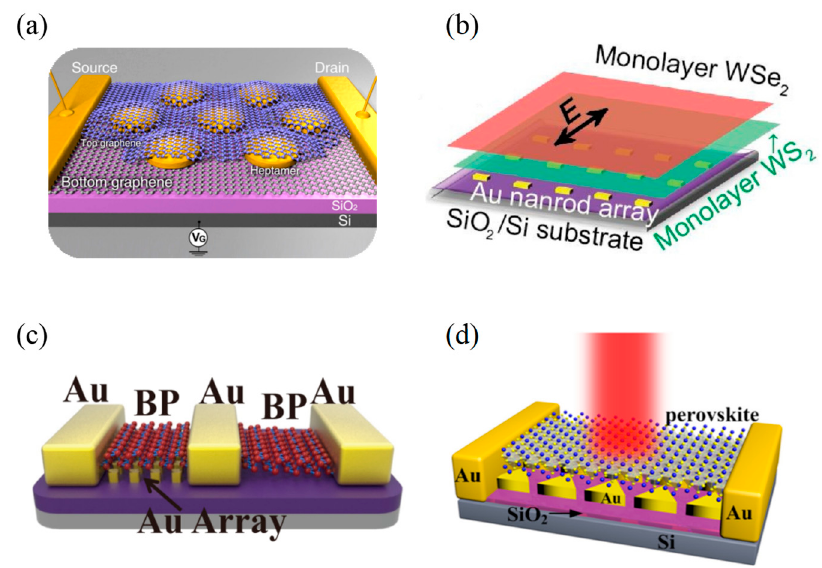
Figure 11. Structures and performance characterization of 2D materials-based infrared PDs with nanoarray structures. ( a ) Schematic diagram of the proposed graphene–antenna sandwich PD [83]. Copyright 2012, Nano Le tt er . ( b ) Schematic representation of WS 2 and WSe 2 heterogeneous bilayers on periodic Au nanorod arrays [85]. Copyright 2020, Photonics Nanostructure . ( c ) Schematic diagram of the BP PD with metal array structure [86]. Copyright 2021, IEEE Trans Electron Devices . ( d ) Schematic diagram of the hybrid PD combined with the Au triangle array [87]. Copyright 2021, Materials & Design.